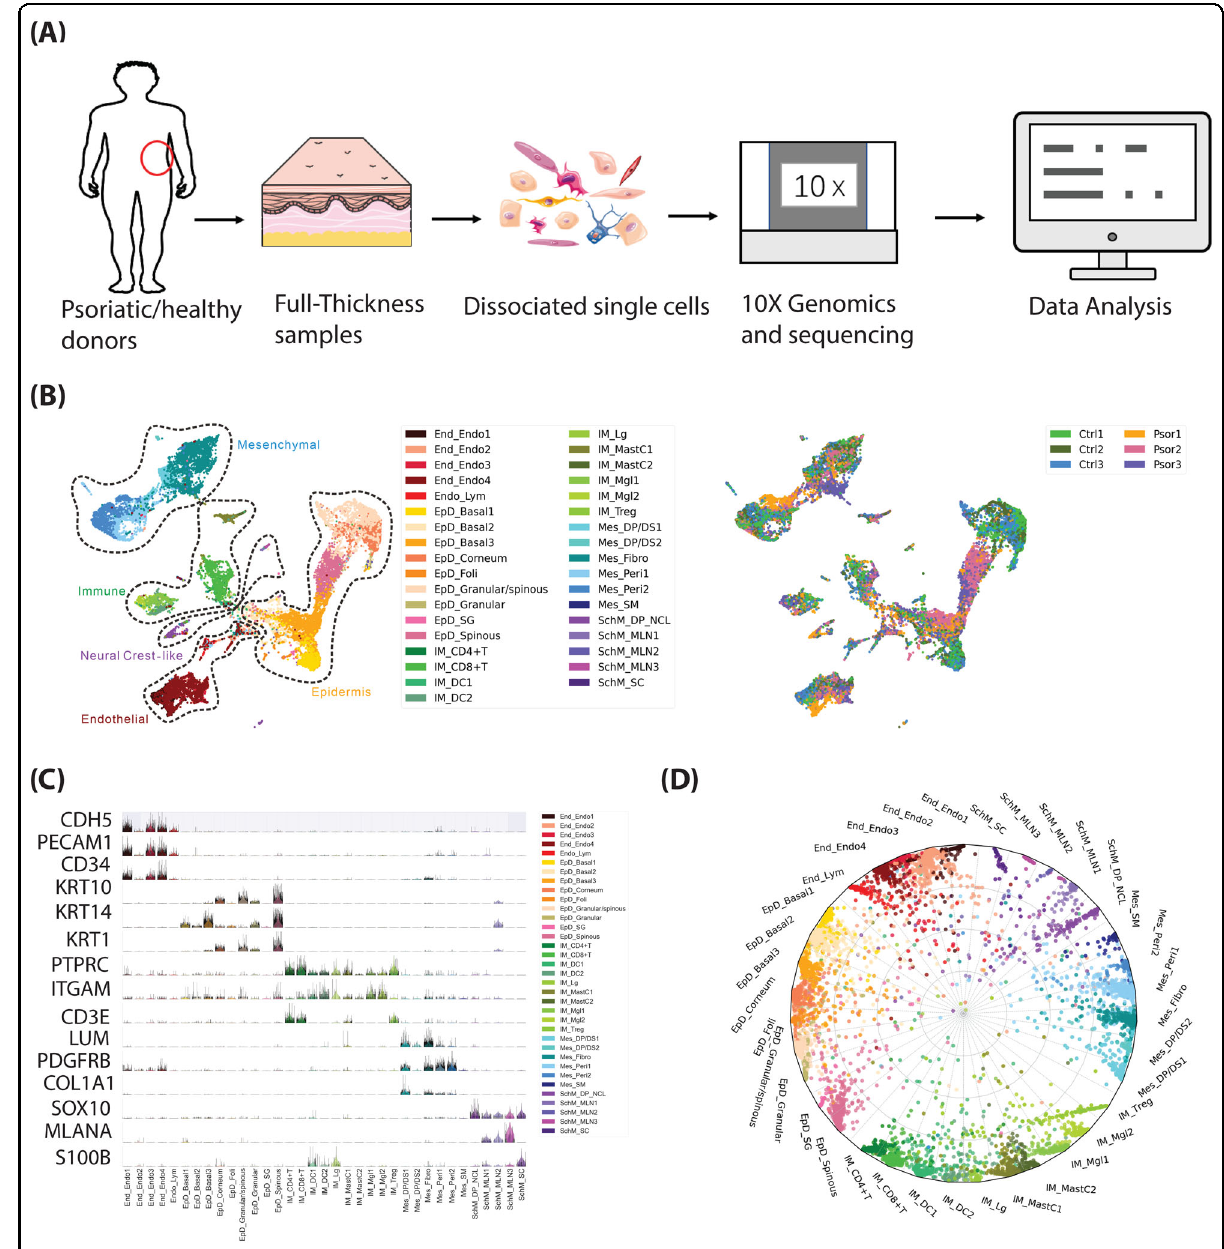
Fig. 1 Clustering, marker genes and cell type assignment of human full-thickness skin scRNAseq from healthy and psoriatic donors. A Schematic view of the work fl ow. B Left, human full-thickness skin cell types. Visualization using UMAP of skin cells, each point represents one cell. Color coding based on unique cell clusters, as shown at right beside. Right, UMAP plot was folked from left side and colored by samples. Ctrl 1 – 3, samples from healthy donors; Psor 1 – 3, samples from patients with psoriasis vulgaris. C Expression of selected top signi fi cant marker genes for fi ve main cell type clusters; relative expression of each gene in each cluster was visualized as violin plot, and the raw counts of each gene were visualized as sparkline plot in that violin plot. D Radar plot visualization of cell-type probabilistic scores of human full-thickness skin cells in relation to our de fi ned cell types. Each dot represented one cell. Color coding based on unique cell clusters. The position of each dot indicated the cell-type score between that cell and the training (de fi ned) cell types which were indicated outside of each bend in the radar wheel. Almost all cells were correctly assigned to their de fi ned cell